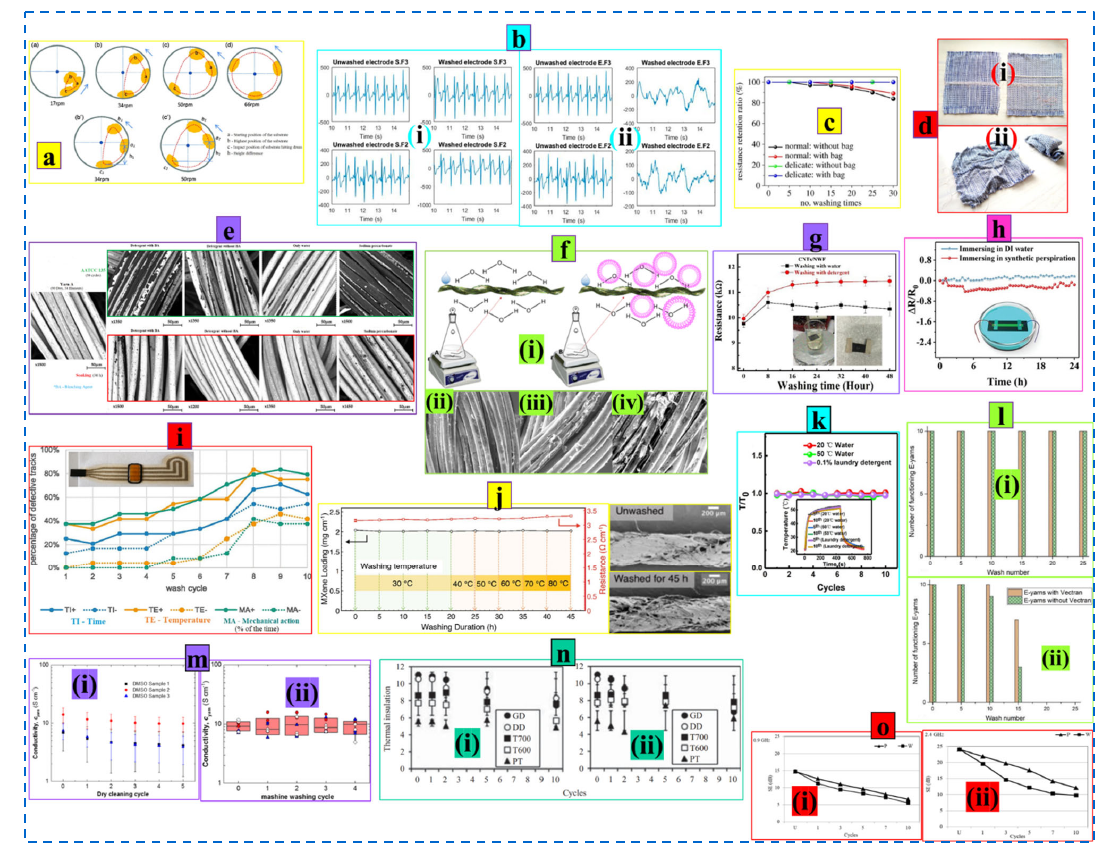
Figure 10. ( a ) Schematic of the fabric movement inside the drum at different rotation speeds. Re- produced with permission [260] Copyright 2020, SAGE Publications. ( b ) ECG measurement of the substrates, i.e., PET fabric/Cu (SF2) and PET fabric/Cu-Ni (SF3) after machine laundry following silk wash program (i) and express wash program (ii). Reproduced with permission [261] Copyright 2020, MDPI. ( c ) Machine washing performance of FCB with/without laundry bag. Reproduced with per- mission [263] Copyright 2014, The Royal Society. ( d ) Photographs of the e-textile substrate before (i) and after machine wash (ii). Reproduced with permission [258] Copyright 2019, Springer. ( e ) Surface morphology of the silver-plated textile electrodes upon different washing techniques under variant aqueous environments. Reproduced with permission [264] Copyright 2020, MDPI. ( f ) (i) Schematic of the water and detergent washing process, (ii) SEM images of the silver-coated polyamide yarn before washing, (iii) after 72 h of detergent washing, and (iv) only water washing. Reproduced with permission [265] Copyright 2019, Springer. ( g ) Water and detergent washing assessment of nonwoven fabric coated with CNT. Reproduced with permission [266] Copyright 2020, Elsevier. ( h ) E-textiles immersion in water and perspiration medium for 24 h. Reproduced with permission [267] Copyright 2022, Wiley. ( i ) Effect of time, temperature, and mechanical actions on the washability of the textile printed circuit board. Reproduced with permission [268] Copyright 2020, Taylor & Francis. ( j ) Influence of temperature on the washing performance of MXene-coated cotton yarn. Reproduced with permis- sion [269] Copyright 2019, Wiley. ( k ) Effect of temperature underwater washing. Reproduced with permission [270] Copyright 2021, American Chemical Society. ( l ) Influence of after-machine wash drying techniques, (i) m/c wash—line dry, (ii) m/c wash—tumble dry. Reproduced with permission [271] Copyright 2020, MDPI. ( m ) Dry cleaning (i) and aqueous machine washing (ii) performance evaluation of conductive yarn. Reproduced with permission [254] Copyright 2017, American Chemical Society.